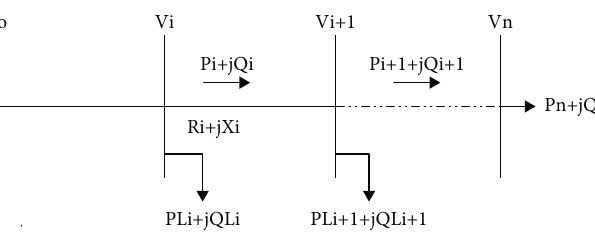
Figure 6: Single line diagram of a main